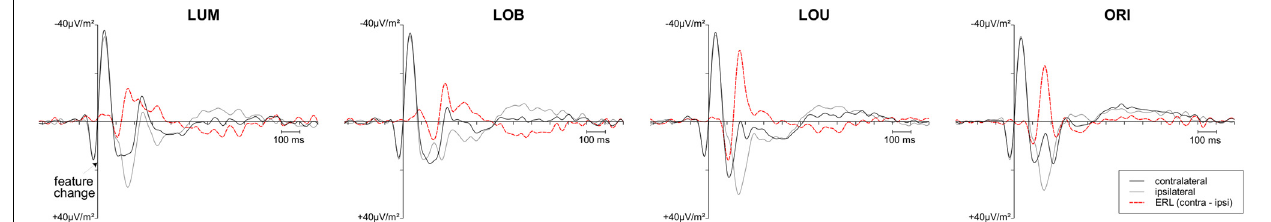
(contralateral ipsilateral difference function) is plotted as a red dashed curve. Although an overlap of the P2 related to the first stimulus display and early sensory components related to the target display were revealed in the contralateral and ipsilateral ERPs, the ERL revealed a clear pattern of posterior asymmetries associated with lateralized target processing.